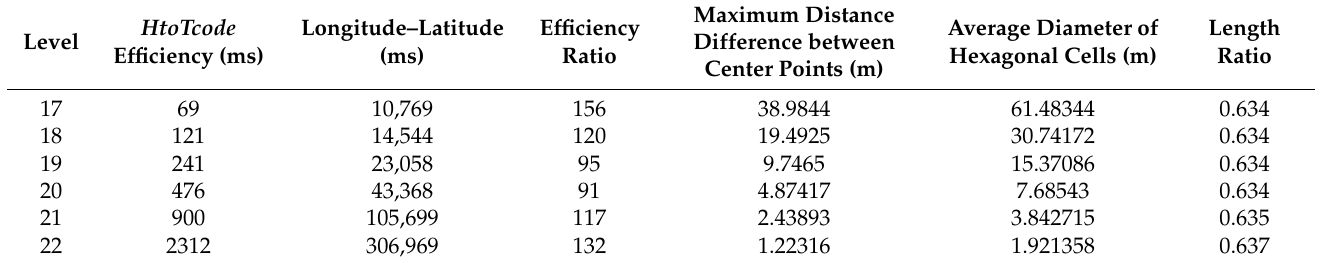
Table 18. Comparison of efficiency and accuracy of HtoTcode and longitude–latitude expressing discrete lines.